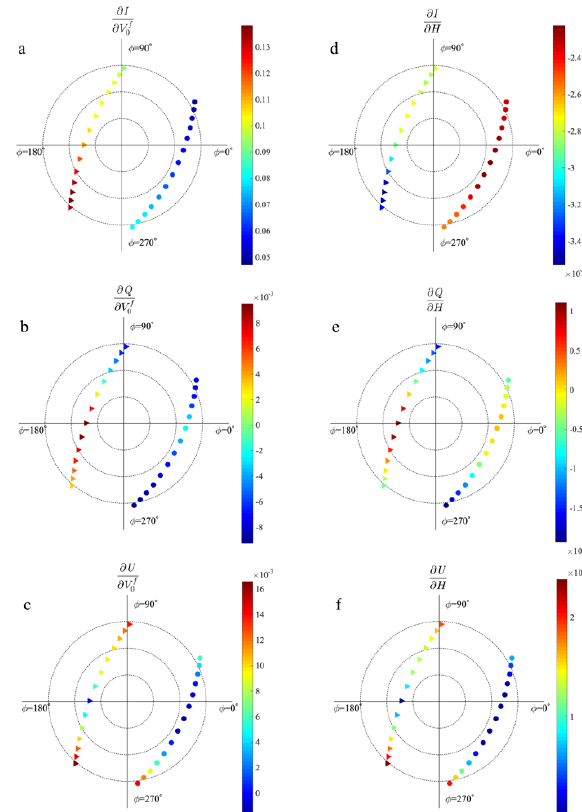
Figure 6. The angular distribution of Jacobians of TOA Stokes elements 𝐼 , 𝑄 and 𝑈 with respect to 𝑉 0f (a-c) and 𝐻 (d-f) the in 410 nm.